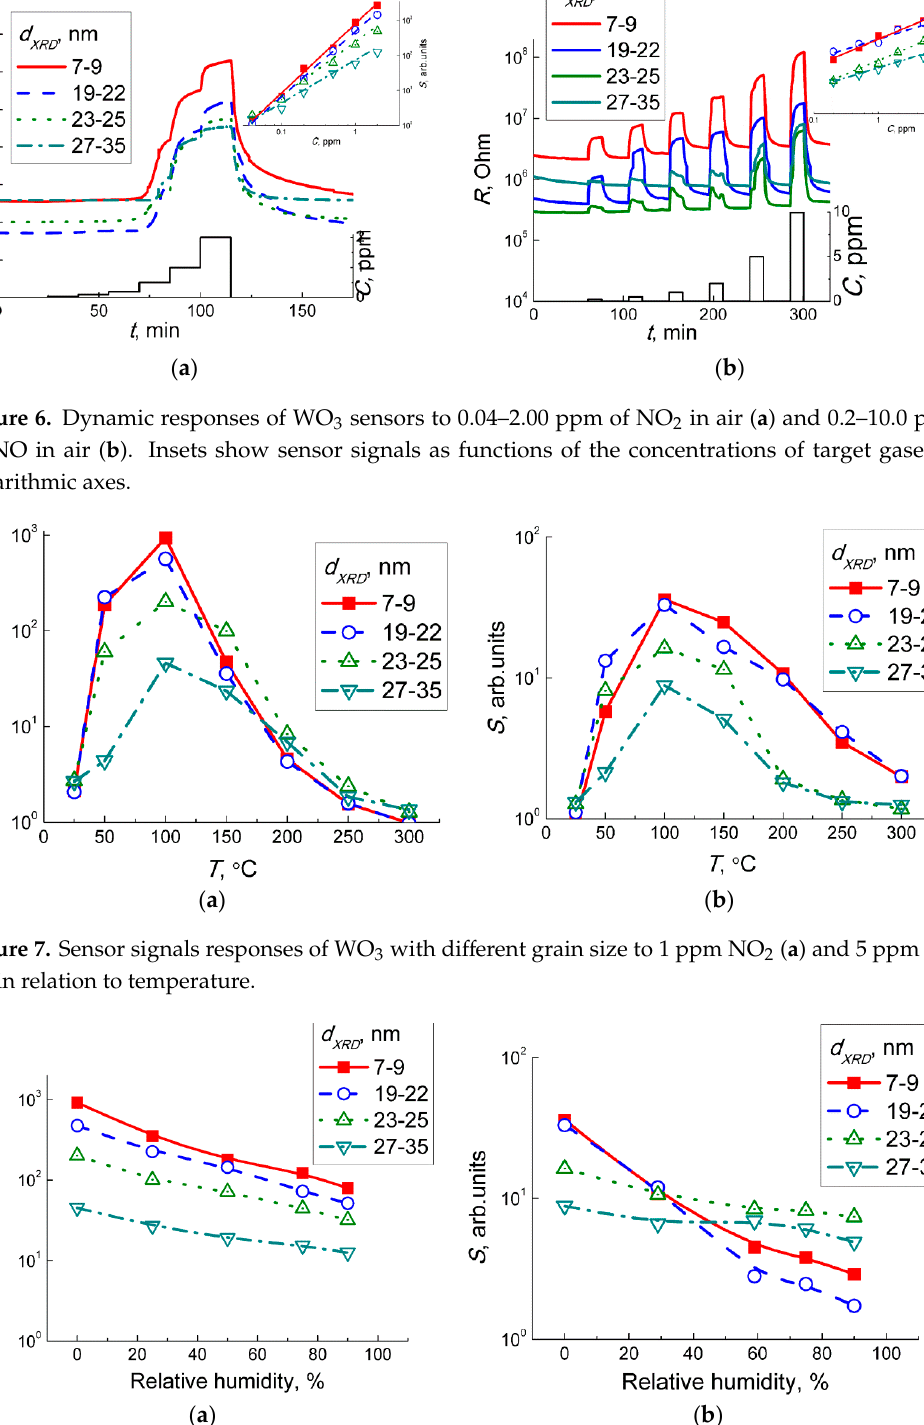
Figure 8. Sensor signals of WO 3 with different grain size to 1 ppm NO 2 ( a ) and 5 ppm NO ( b ) at 100 ° С and different relative humidity.